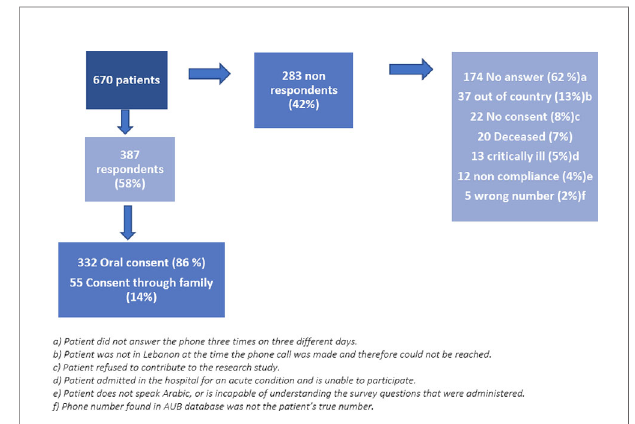
FIGURE 1 | Summary of